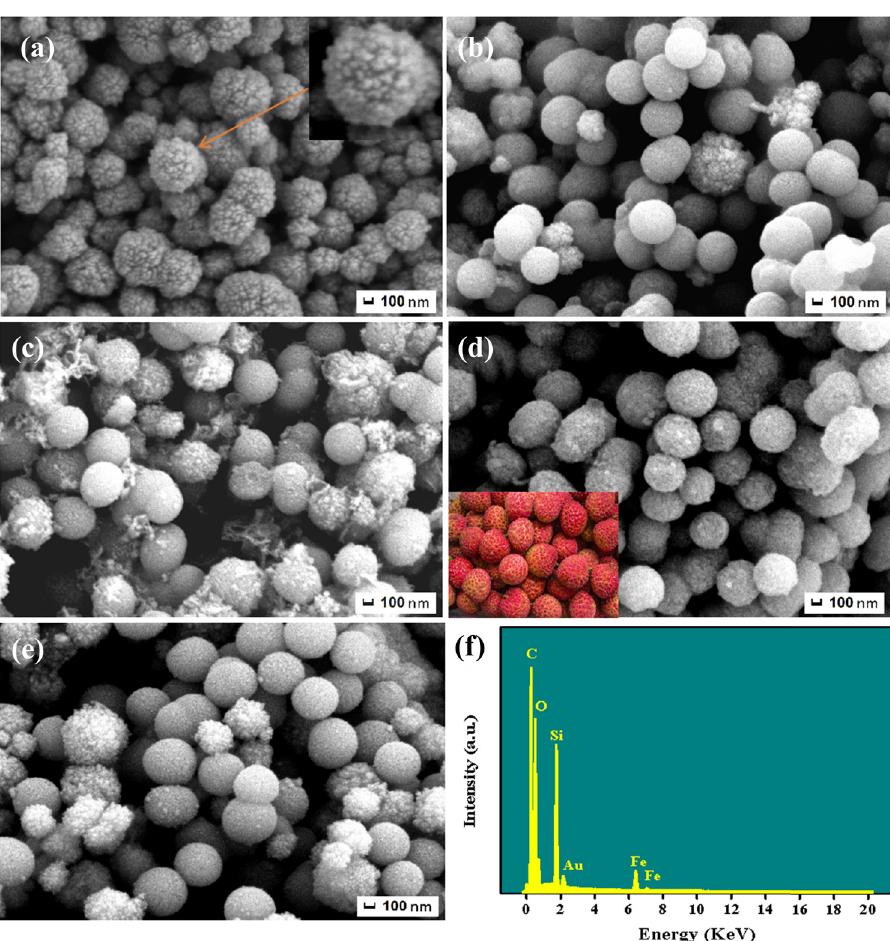
Figure 2: SEM images of ( a ) Fe 3 O 4 , ( b ) Fe 3 O 4 @SiO 2 , ( c ) Fe 3 O 4 @SiO 2 @Au, ( d ) FSA - MIPs, and ( e ) FSA - NIPs. ( f ) EDS spectrum of the FSA -